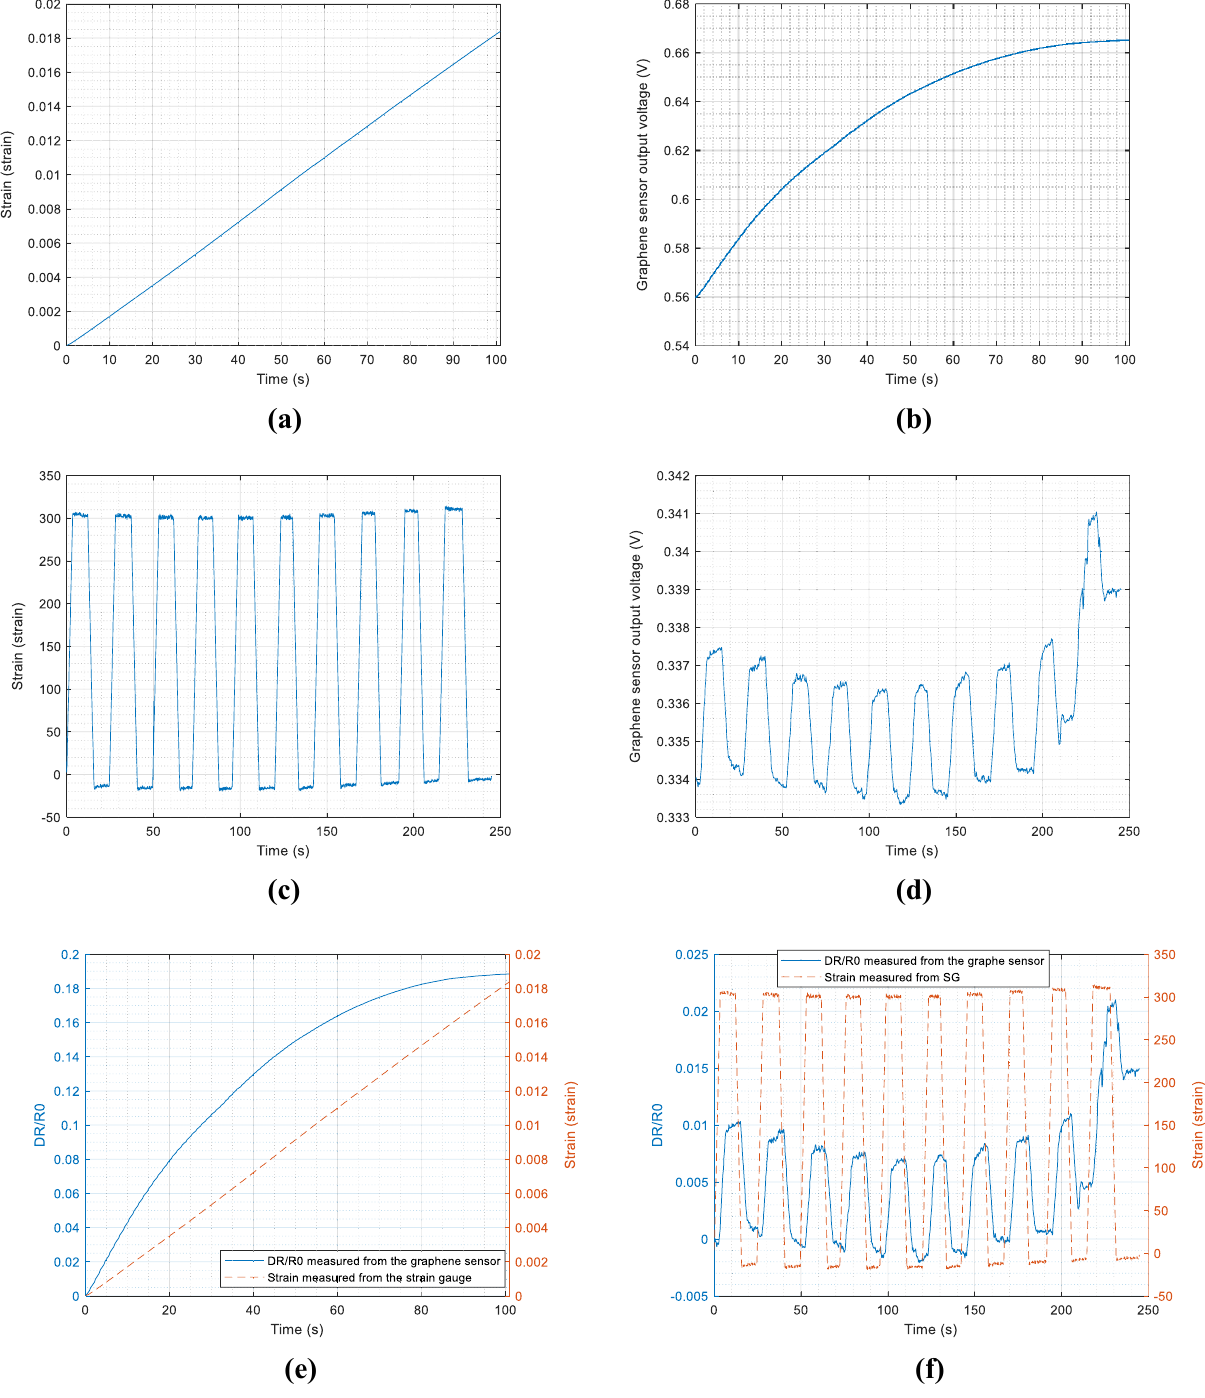
Fig. 10 Strain measurement obtained from a strain gauge a and graphene sensor output voltage b for a normal tensile load applied to a GFRP sample and 10 cycles cyclic tensile load c and d , respec- tively and resistance change comparison for the graphene-based